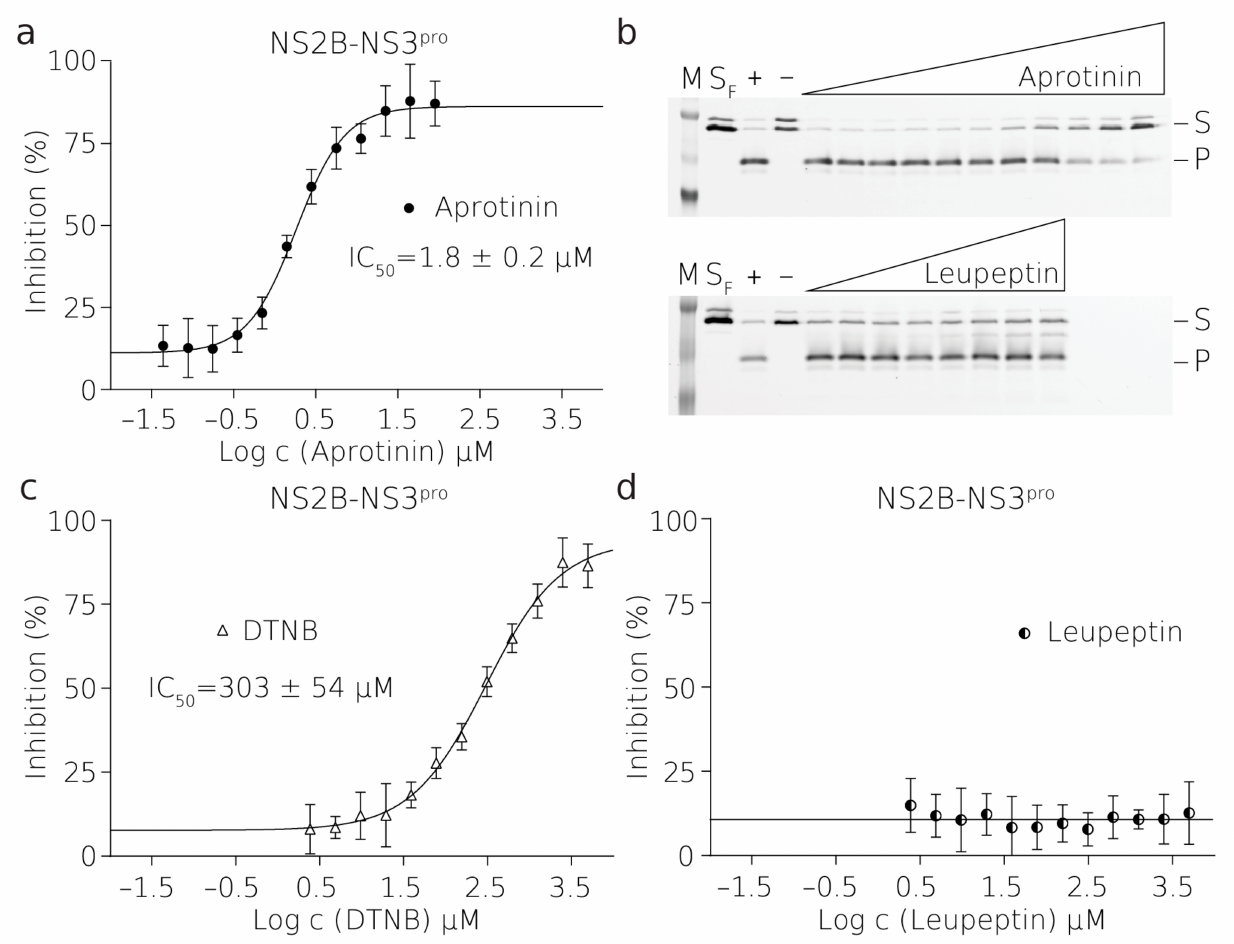
Figure 2. Inhibition of TBEV NS2B–NS3 pro by small molecules. Curves derived from the FRET inhibition assays of ( a ) aprotinin, ( c ) DTNB, and ( d ) leupeptin. Each curve is derived from three experiments. ( b ) Validation by SDS-PAGE analysis showing the successful inhibition by aprotinin (top) and no inhibition by leupeptin (bellow) where (M) is a marker, (SF) is fresh substrate at reaction concentration, (+) is positive control reaction where there was no inhibitor present, (–) is negative control reaction where there was no enzyme present, (S) is the substrate, (P) is the product. The illustrative evaluations of the validation SDS-PAGE gels and more details are shown in Figure